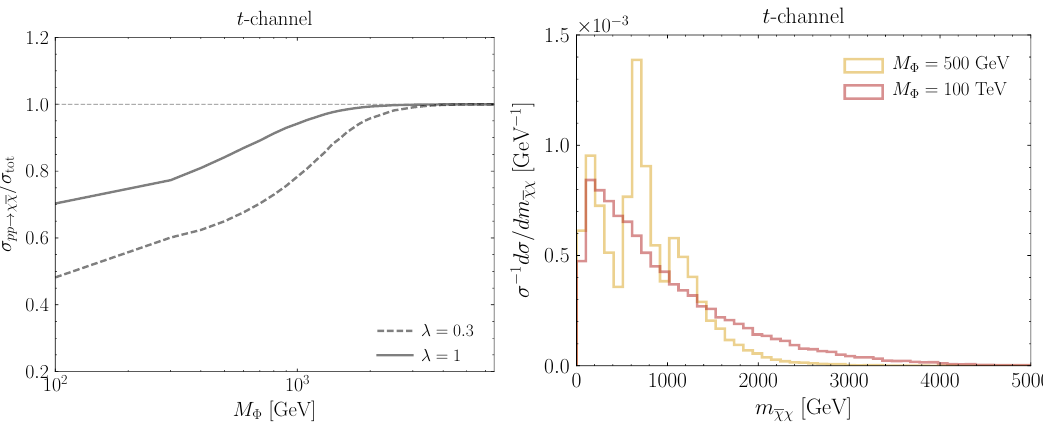
Figure 10 . (Left) Ratio of the t -channel direct production cross section to the total cross section as a function of the bi-fundamental mass. The total cross section includes processes with additional quarks in the (cid:12)nal states through (cid:8) ai (cid:31) q i . The t -channel production mode accounts for a a ! larger proportion of the total cross section as the mediator mass is increased towards the contact operator limit. (Right) The parton-level invariant mass distribution for the (cid:31) (cid:31) particles, m (cid:31)(cid:31) , for M (cid:8) = 500 GeV and 100 TeV (the contact operator limit) and (cid:21) = 1. One can clearly identify the threshold as each production channel turns on. This shows that the high (cid:31) (cid:31) tail falls o(cid:11) more rapidly when M (cid:8) is light, which results in weaker